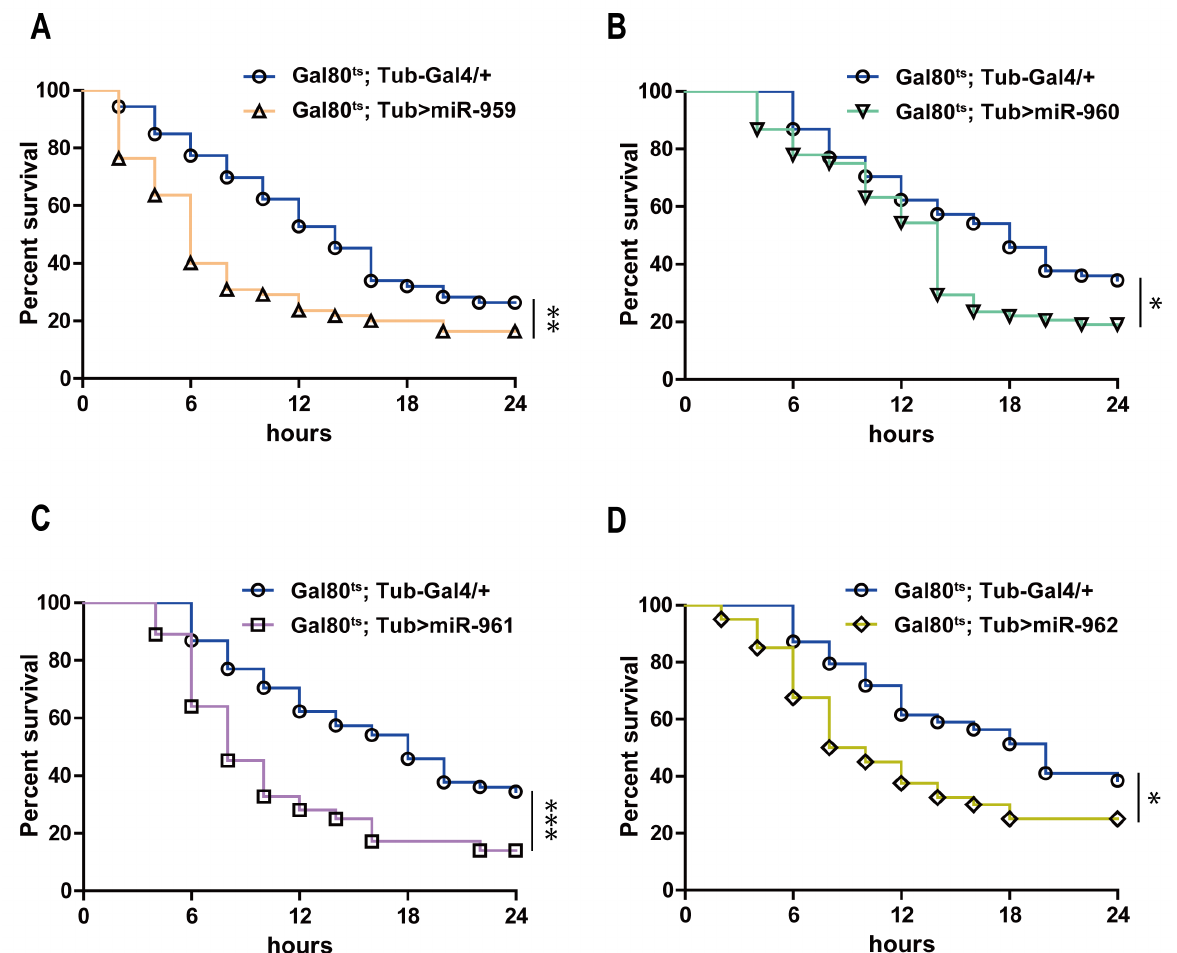
Figure 3. Each of miRNA member from miR-959–962 clusters influences the survival of Drosophila . The changes of the survival rate were observed in miR-959 high-expressing flies ( A ), miR-960 high-expressing flies ( B ), miR-961 high-expressing flies ( C ) and miR-962 high-expressing flies ( D ), as well as the control flies upon E. faecalis infection. (* p < 0.05; ** p < 0.01; *** p <